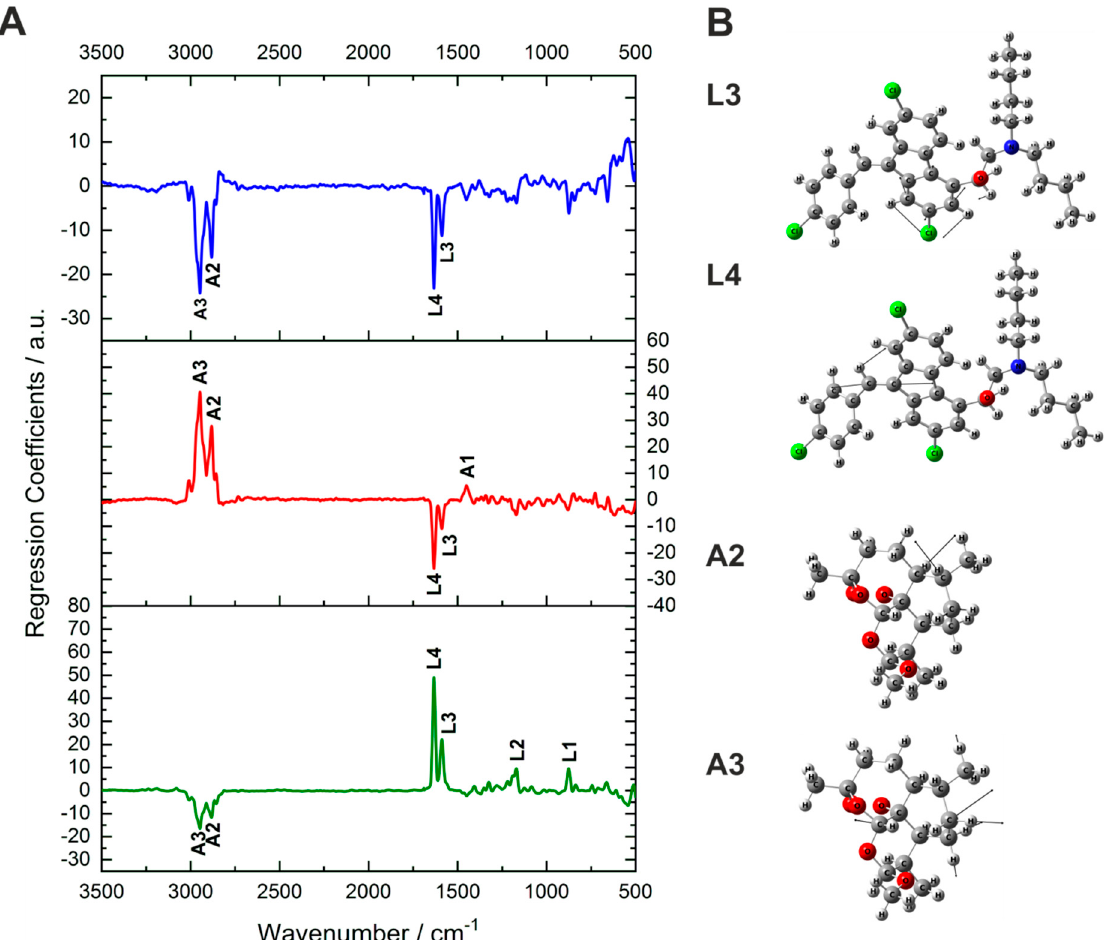
Figure 3. ( A ): Regression coe ffi cients for the prediction of lumefantrine (green, lower part), artemether (red, middle part), and hypromellose (blue, upper part). The coe ffi cients from the first two factors for each analyte correlate perfectly to the characteristic Raman bands of lumefantrine and artemether. Strong contribution for the di ff erentiation is attributed to the peaks L4, L3, A3, and A2. ( B ): Vibrational assignment of the peaks that contribute most to the PLSR model: L3: benzene ring stretching + CH scissoring, L4: C = C stretching vibration + CH scissoring, A2: asymmetric stretching vibration + slight contribution from CH stretching, A4: asymmetric CH 2 stretching vibration.